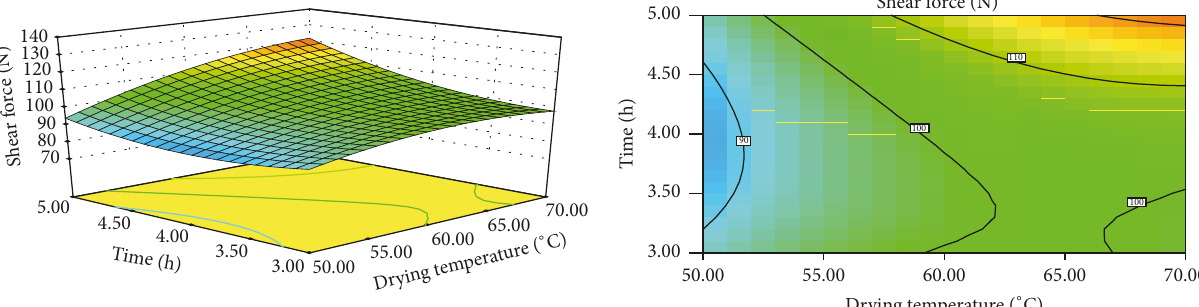
Figure 5: 3D response surface and contour plots for the effect of drying temperature and time on shear force value of SLS.